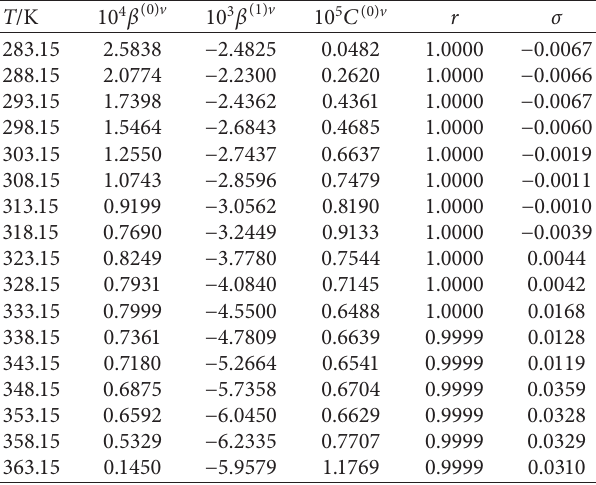
Table 6: Pitzer single-salt parameters of YCl temperatures a .